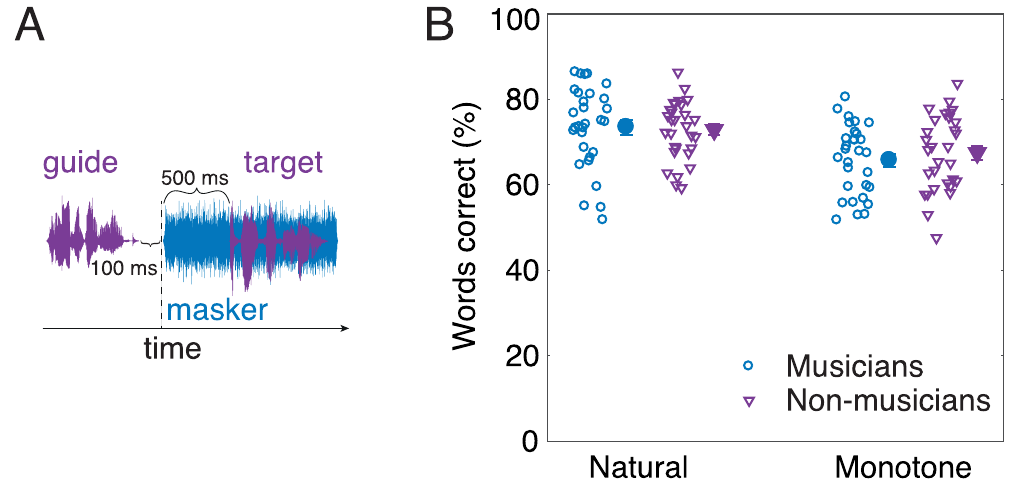
Figure 2. ( A ) Schematic diagram of the stimuli used in the experiment. ( B ) Proportion of words correctly identified for natural and monotone speech masked by speech-shaped noise. Individual speech scores (open symbols) and means across participants in each group (solid symbols). Error bars indicate ± 1 standard errors of the mean.